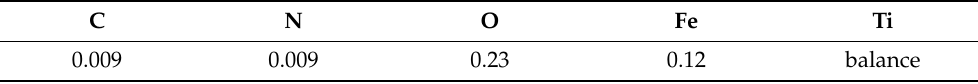
Table 1. Chemical composition of the CP Grade 2 titanium sheet selected (in weight%).